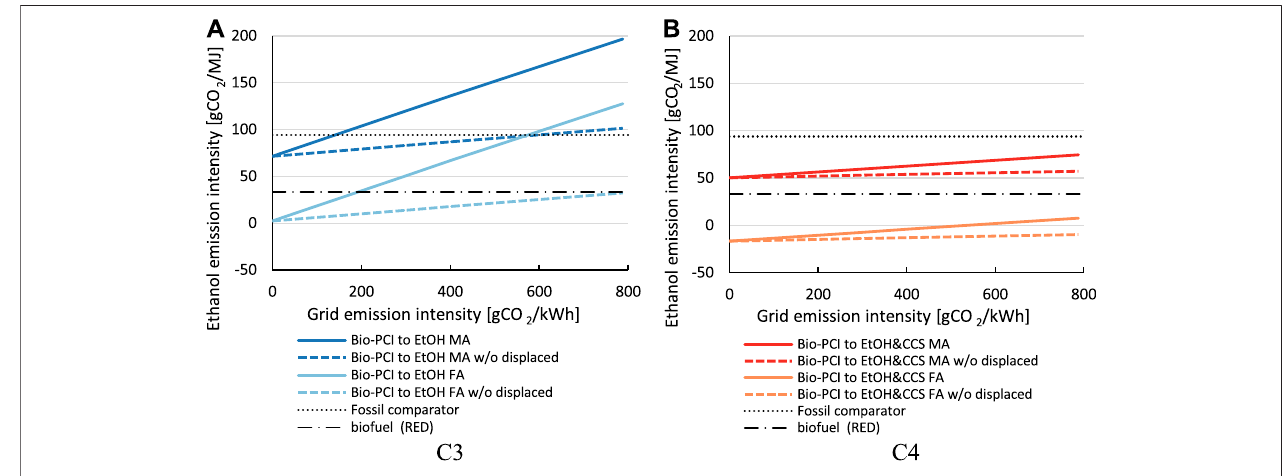
FIGURE 12 | CO 2 emission intensities of produced ethanol depending on the CO 2 emission intensity of imported electricity for Bio-PCI to ethanol con fi gurations without CCS (A) and with CCS (B) . The dashed lines represent the emission intensity of ethanol if the displaced emissions from electricity import due to the diversion of BFG to the syngas fermentation are instead allocated to